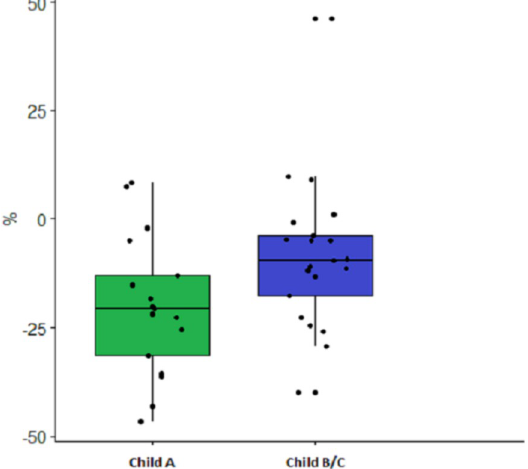
Fig 2. The blunted effect of beta-blockers on cardiac index. The weaker effect of beta-blockers on the cardiac index in Child-Pugh A vs. B/C patients ( p = 0.043). See also Table 3.